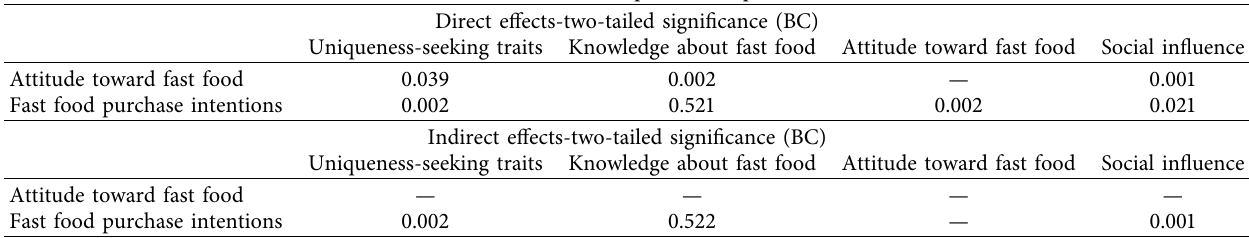
Table 10: Direct and indirect paths on dependent